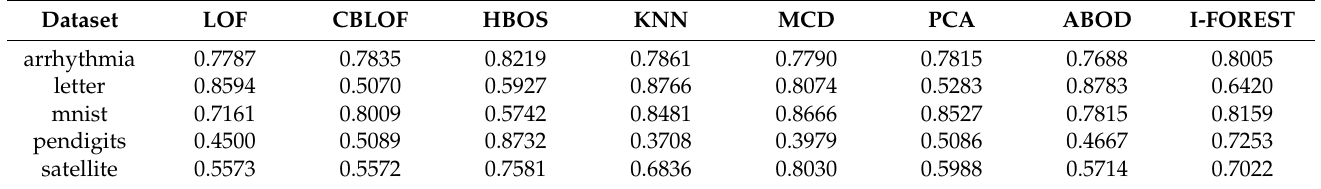
Table 2. Overview of Receiver Operating Characteristics (ROC) performance using the studied algorithms in different datasets. Dataset